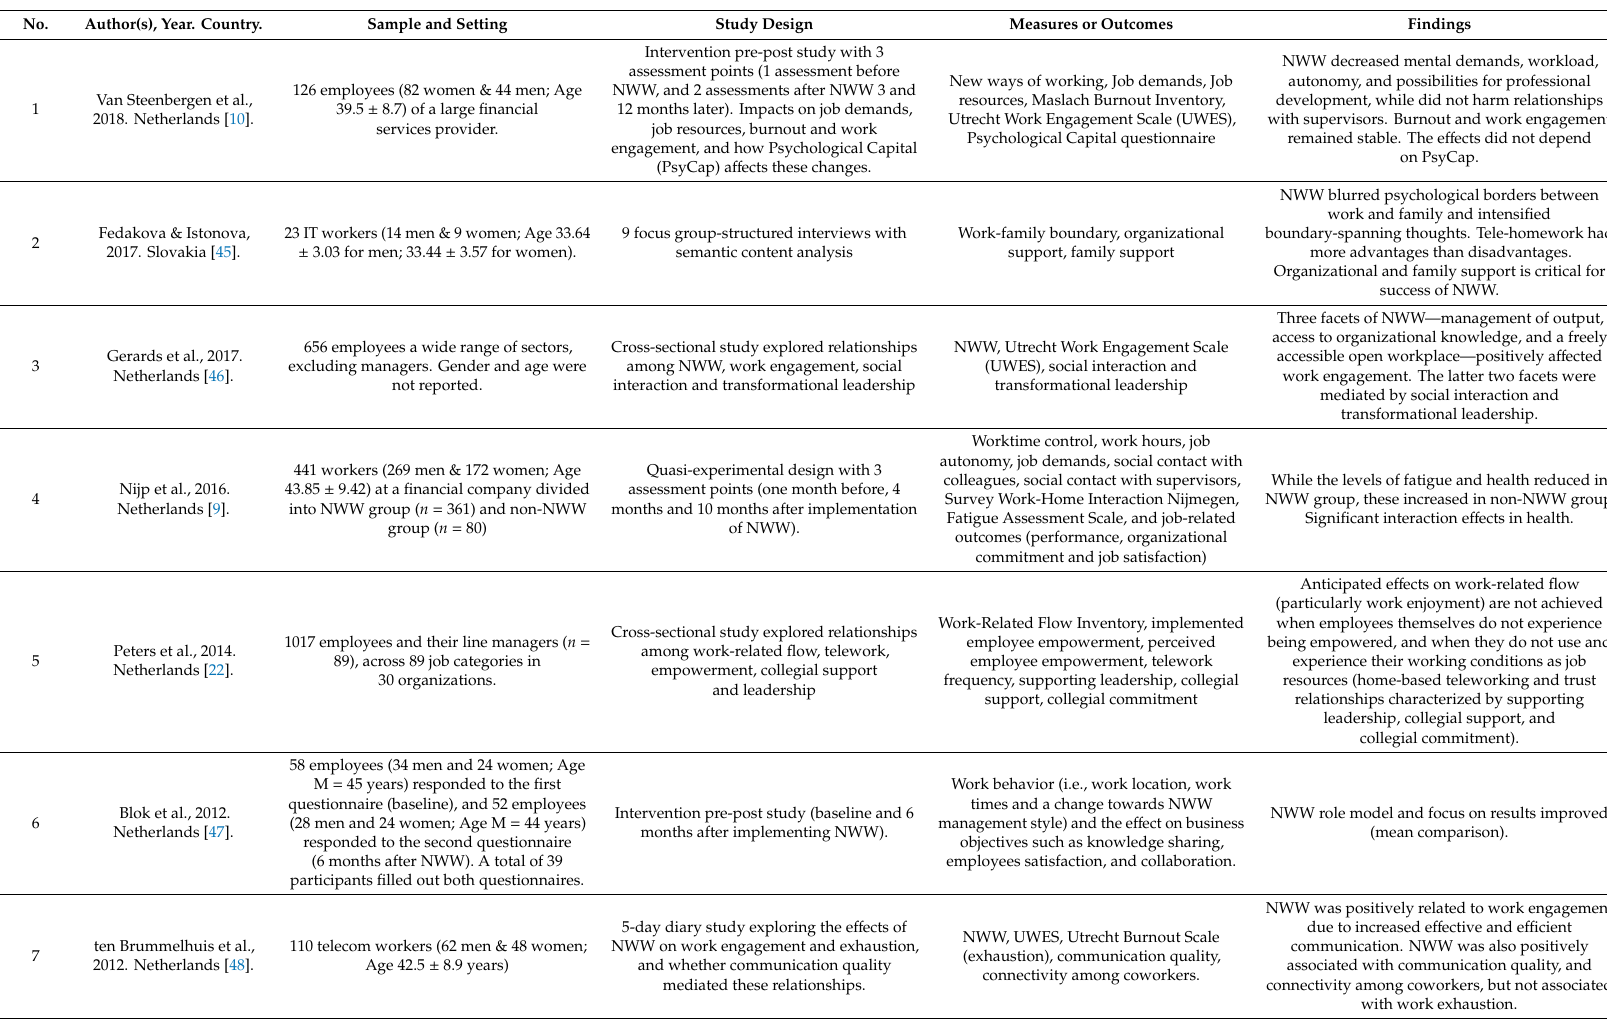
Table 2. Study details of selected articles exploring New Ways of